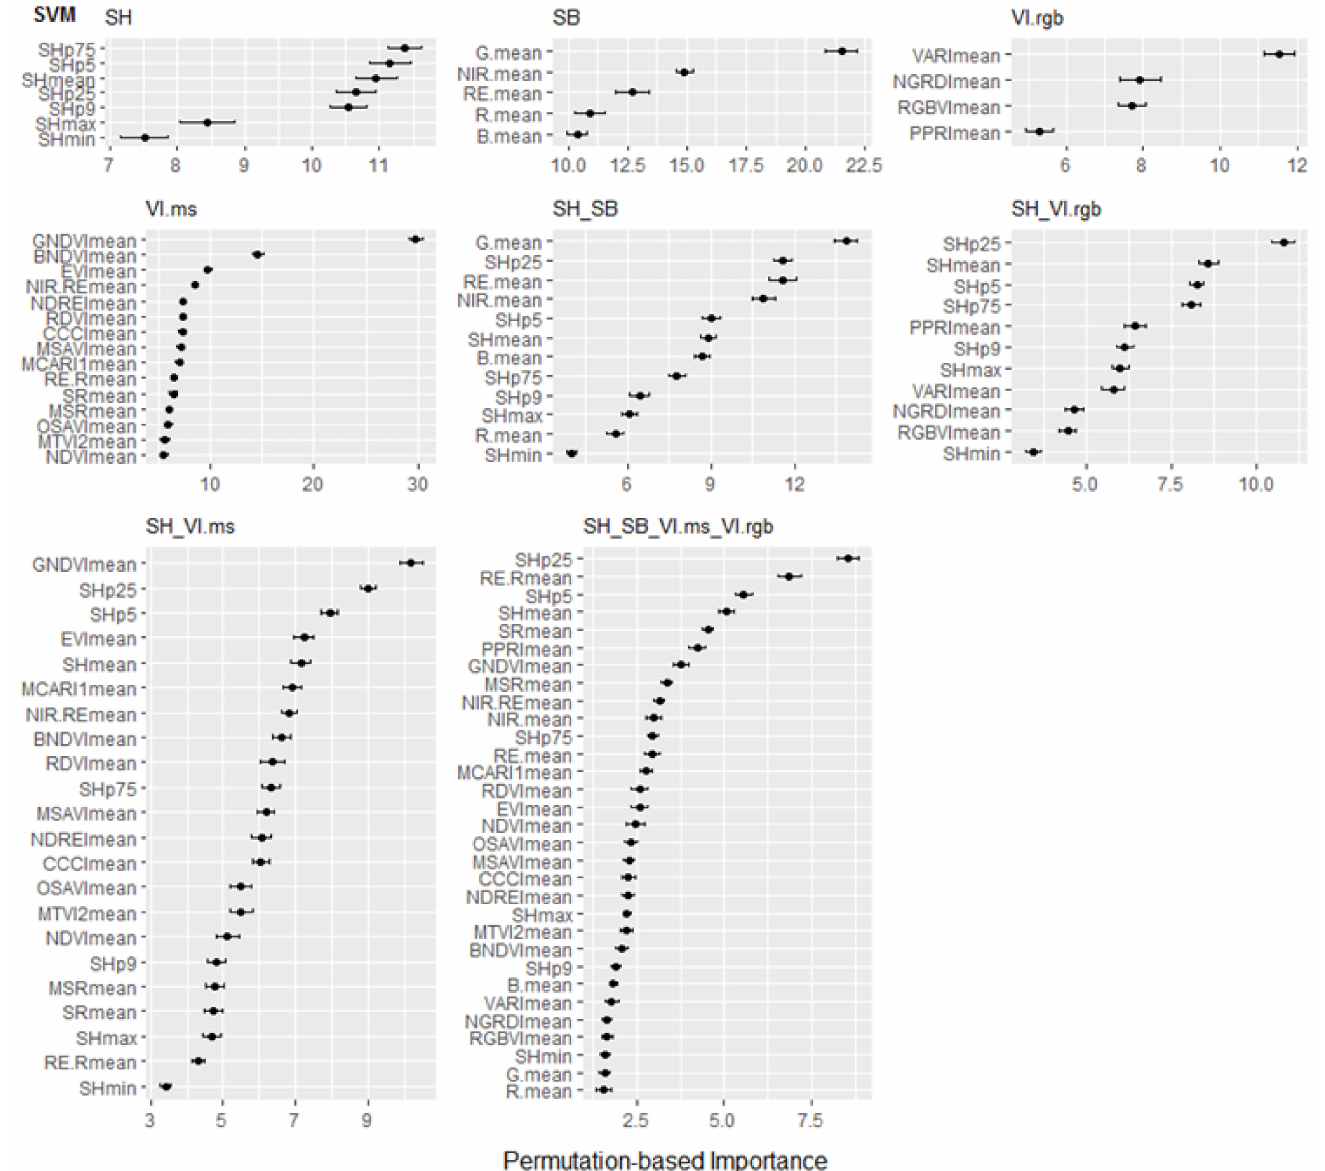
Figure A9. VIP of Nup estimation with